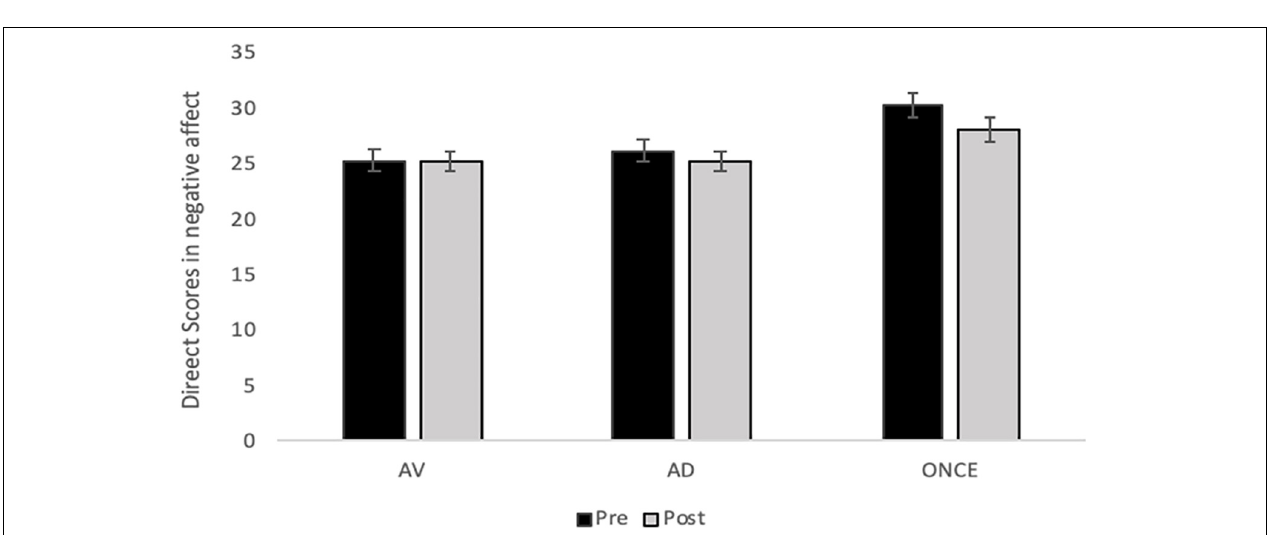
FIGURE 3 | Estimated means of heart rate for each phase of the experimental protocol (Baseline, Task and Recovery). Error bars represent standard error of the mean (SEM).